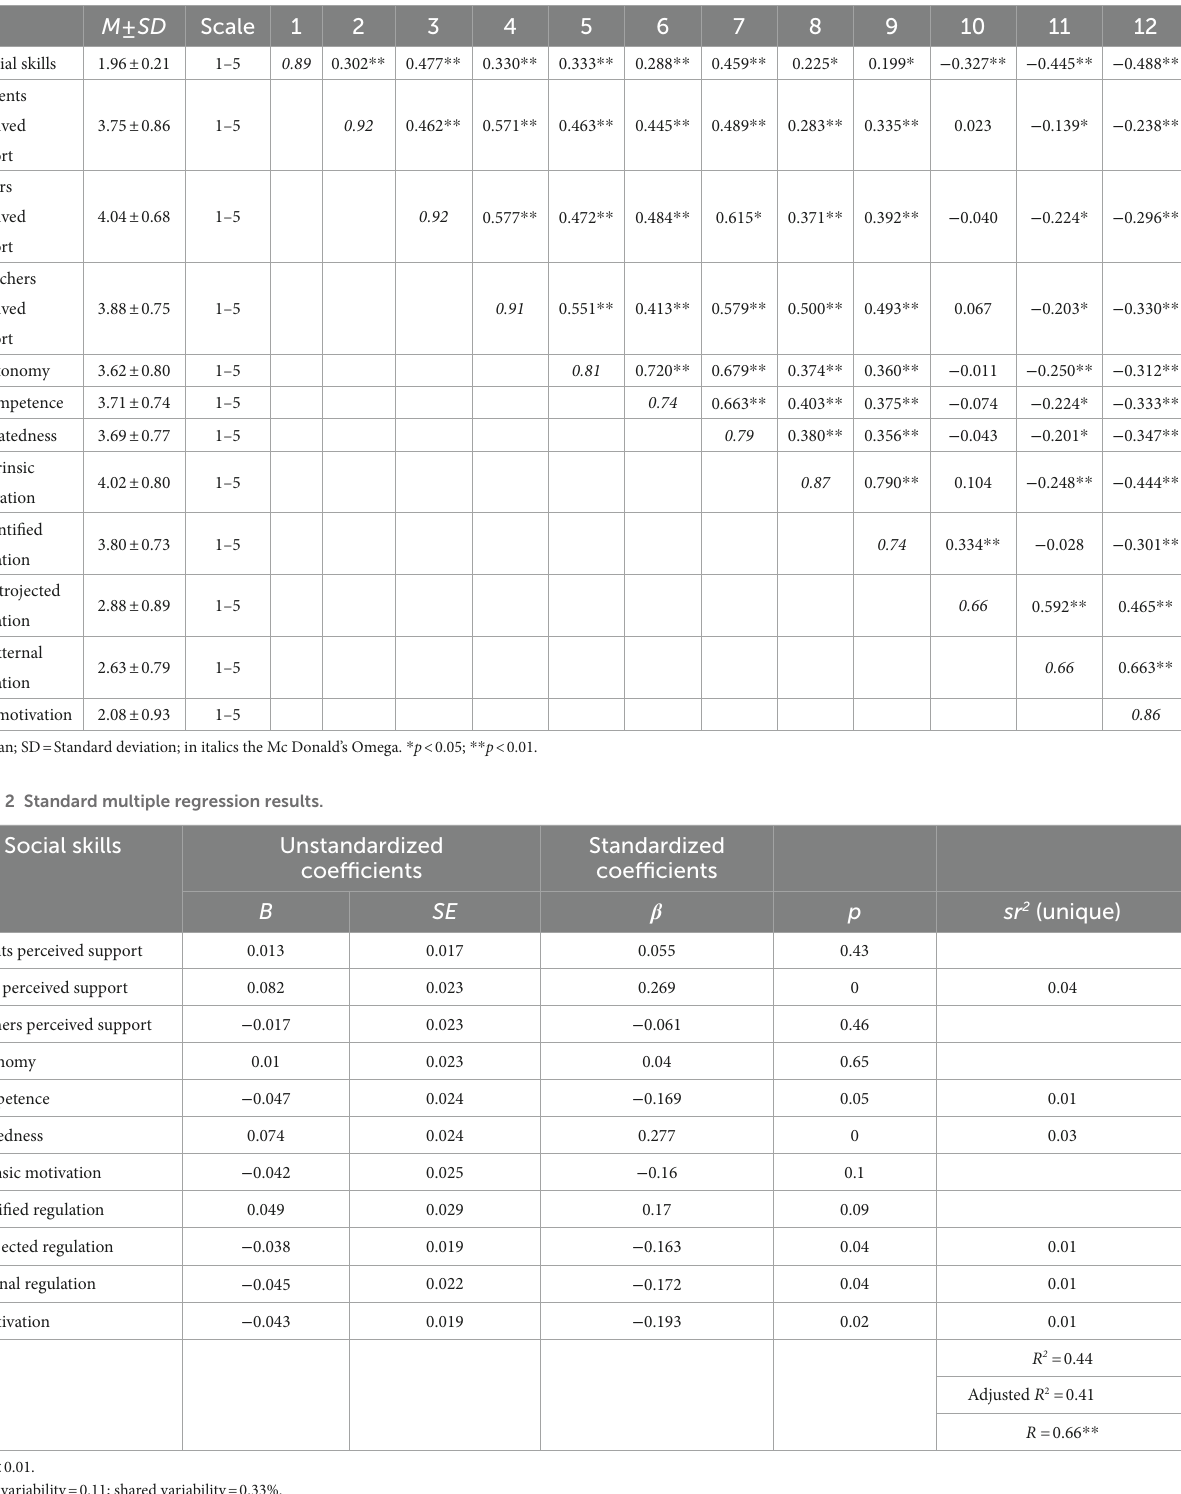
TABLE 1 Descriptive statistics and correlations of study variables.